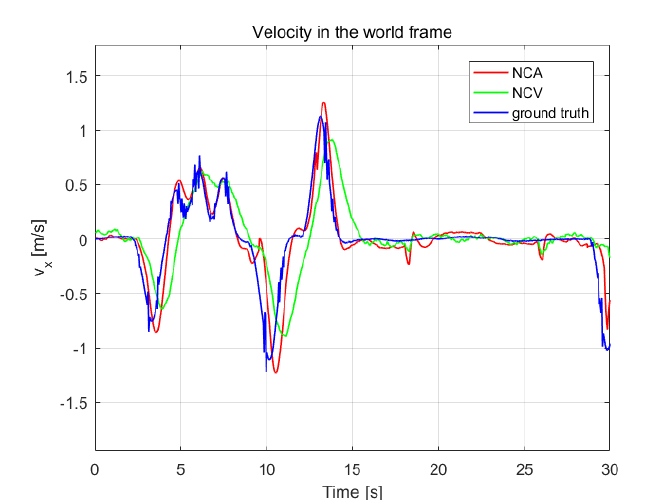
Figure 10. The velocity estimation in the world frame, compared with